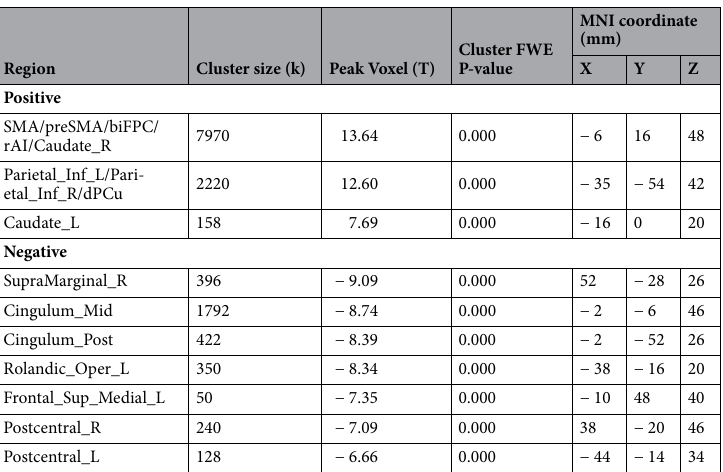
Region Cluster size (k) Peak Voxel (T)